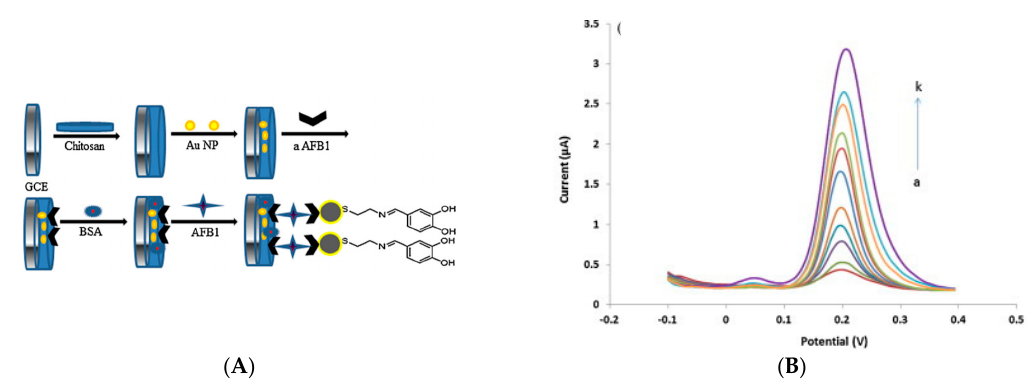
Figure 29. ( A ) GCE/chitosan/AuNP/anti-AFB1/AFB1/anti-AFB1/MB/catechol immunoensor; ( B ) DPV recorded for GCE/chitosan/AuNP/anti-AFB 1 /BSA/AFB 1 /anti-AFB 1 /catechol–Au–Fe 3 O 4 immunoelectrode as a function of AFB 1 concentration from 0 ng mL − 1 to 110 ng mL − 1 in pH 7.0 (scan rate 50 mV s − 1 ). Reprinted from [154], Copyright 2013, with permission from Elsevier;